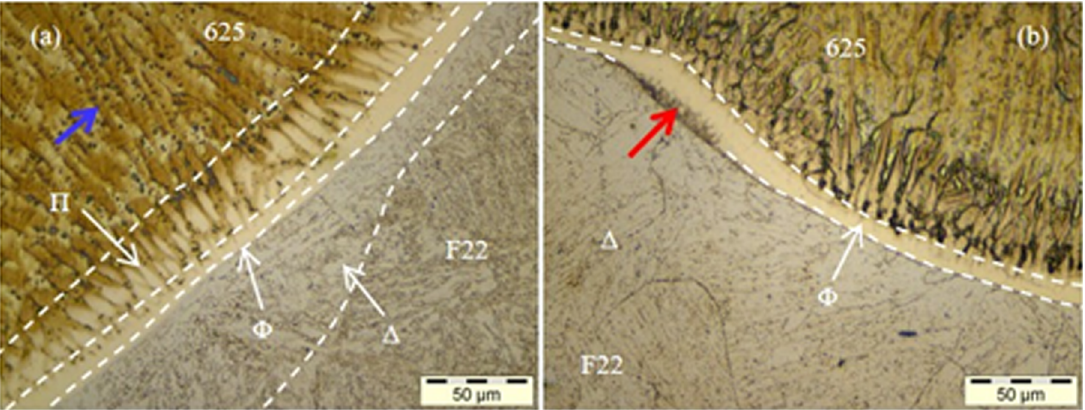
Figure 3. Microstructure, NCS, of the butter-weld interface. (a) as-welded (500x). (b) after PWHT